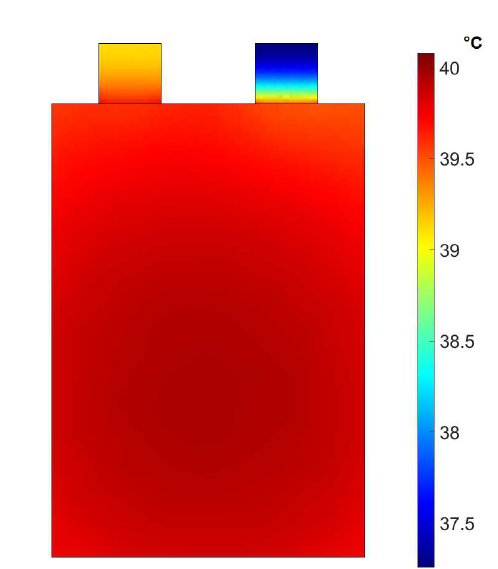
Figure 24. Predicted temperature distribution at the surface of a cycled cell in the end of a high constant current discharge under 35 ◦ C